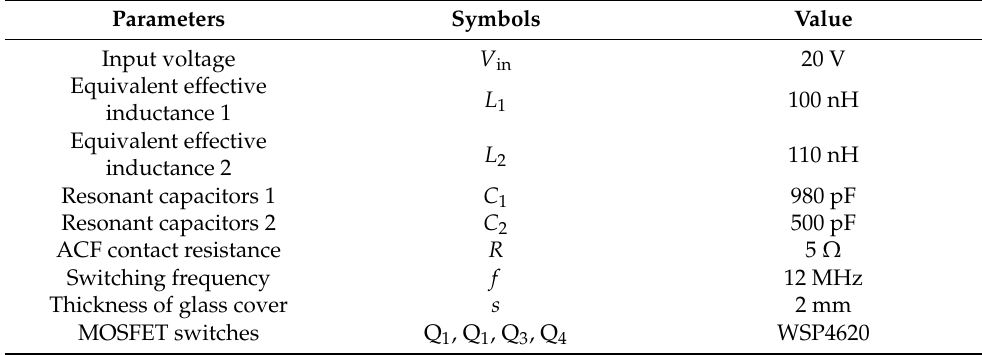
Figure 12. Prototype of the proposed fourth-order LCLC converter to drive an ultrasonic fingerprint sensor. Table 1. Parameters of the prototype.